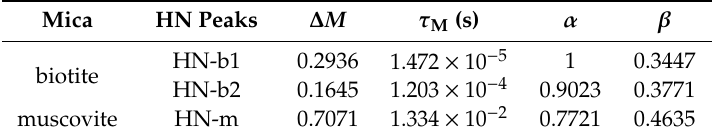
Table 3. Fitting parameters of the (un-normalized) HN relaxation function (Equation (10)) that describes the master curves of biotite and muscovite micas during their gradual cooling (refer to Figure 7a,b). Mica HN Peaks ∆ M τ M (s) α β HN-b1 biotite